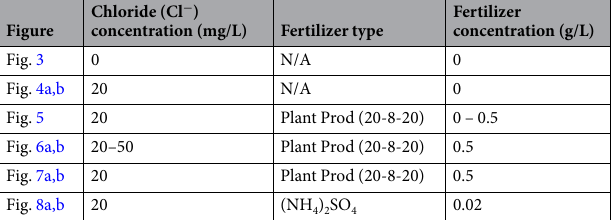
Table 1. Fertigation solution composition summary for each experiment presented. Solution compositions are cross referenced with their respective figures for clarity.